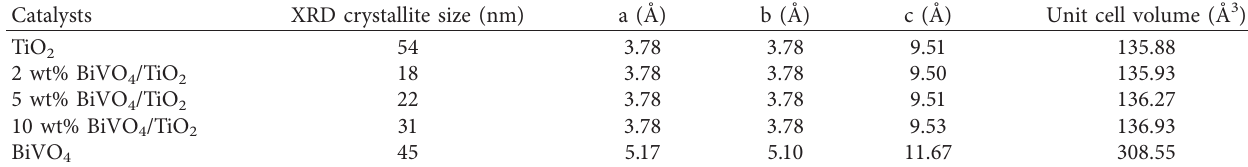
Table 1: Structural parameters of pure TiO